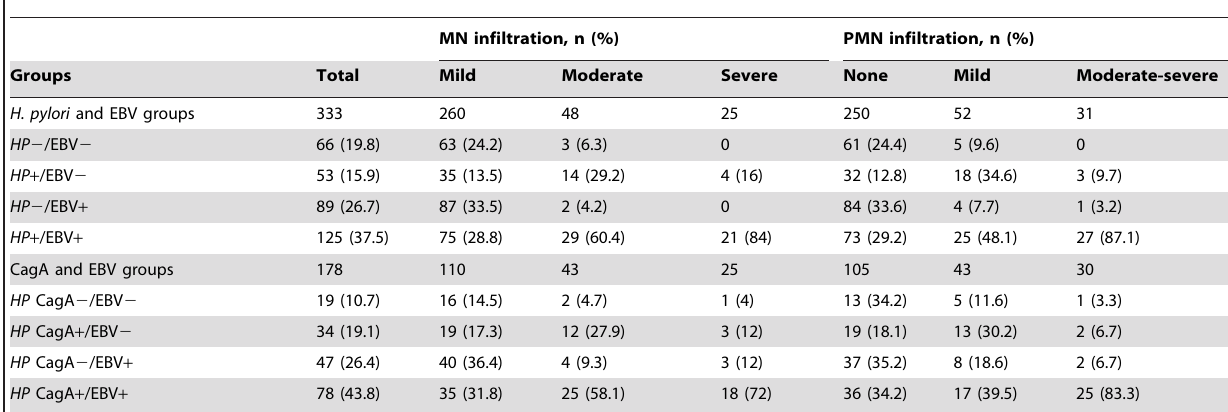
Table 3. Degree of infiltration of mononuclear (MN) and polymorphonuclear (PMN) cells in the gastric mucosa of children according to co-infection with EBV and H. pylori ( HP